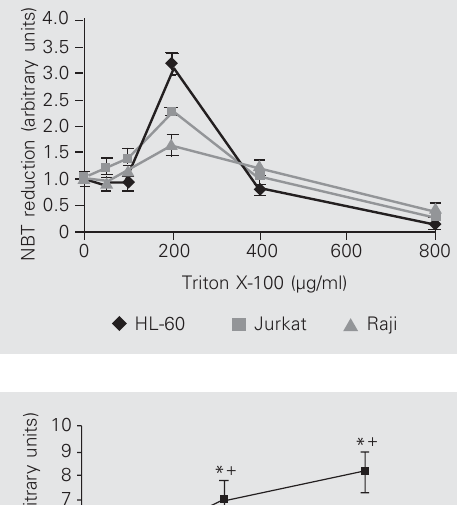
Figure 6. Nitroblue tetrazolium (NBT) reduction upon cell treat- ment with NADPH. HL-60 cells (2 x 10 7 /ml, 150 µl) were treated for 30 min with 0.5% ethanol (EtOH, 0) and with twice the indicated concentrations of NADPH. One volume of PBSG (0.13 mM